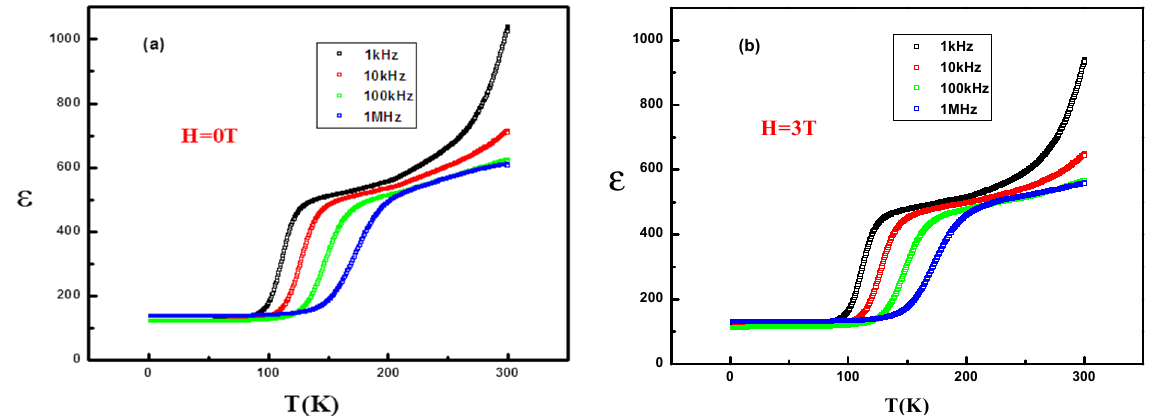
Figure 8. ( a ) Variation of ε as a function of the temperature for the BiMn 2 O 5 sample in the absence of a magnetic field. ( b ) Variation of ε in the presence of a magnetic field (H = 3 tesla) at different frequencies.